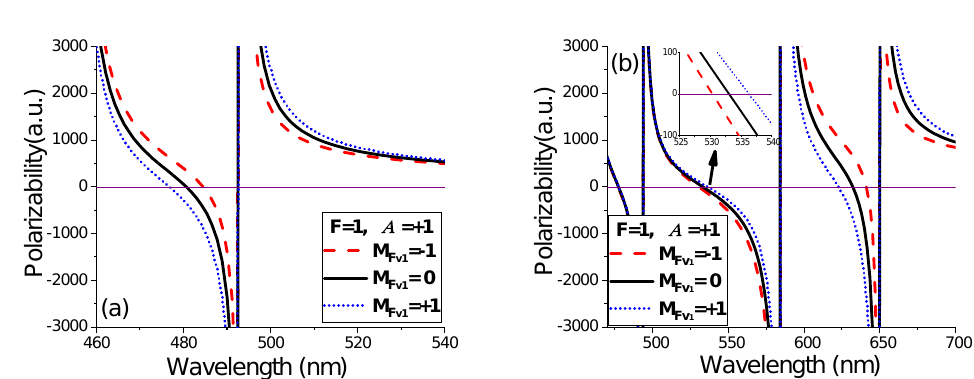
Figure 6. Variations in ( a ) single-photon and ( b ) two-photon polarizabilities with wavelength for = 0, ± 1 ) state of 137 Ba + ion. In the single-photon case, we assume a left the 6 2 S 1/2 ( F v 1 = 1, M F v 1 circularly polarized light. In the two-photon case, we assume a left circularly polarized light and a linearly polarized light. In the inset of the panel in ( b ), we display the enlarged version of the plot around the wavelength 533.08